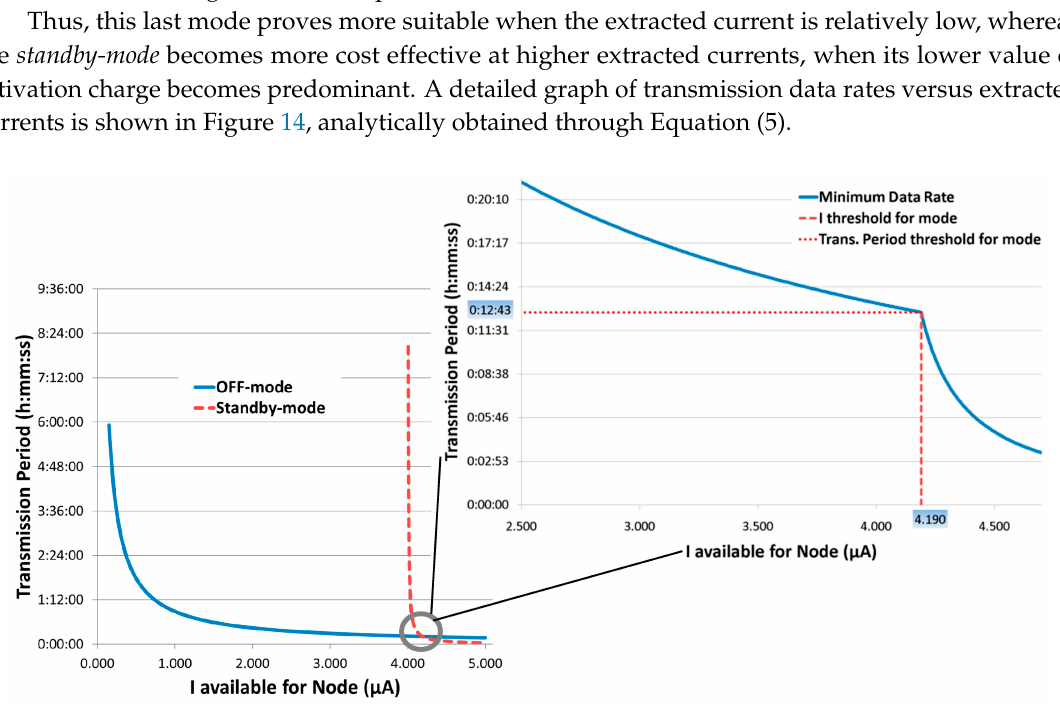
Figure 14. Transmission period vs. Extracted currents in different operating modes.